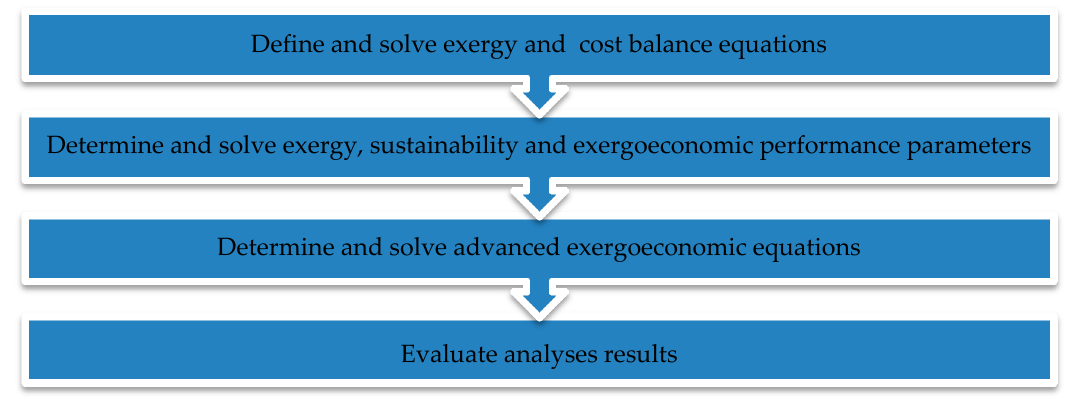
Figure 2. A flow process of the analyses.